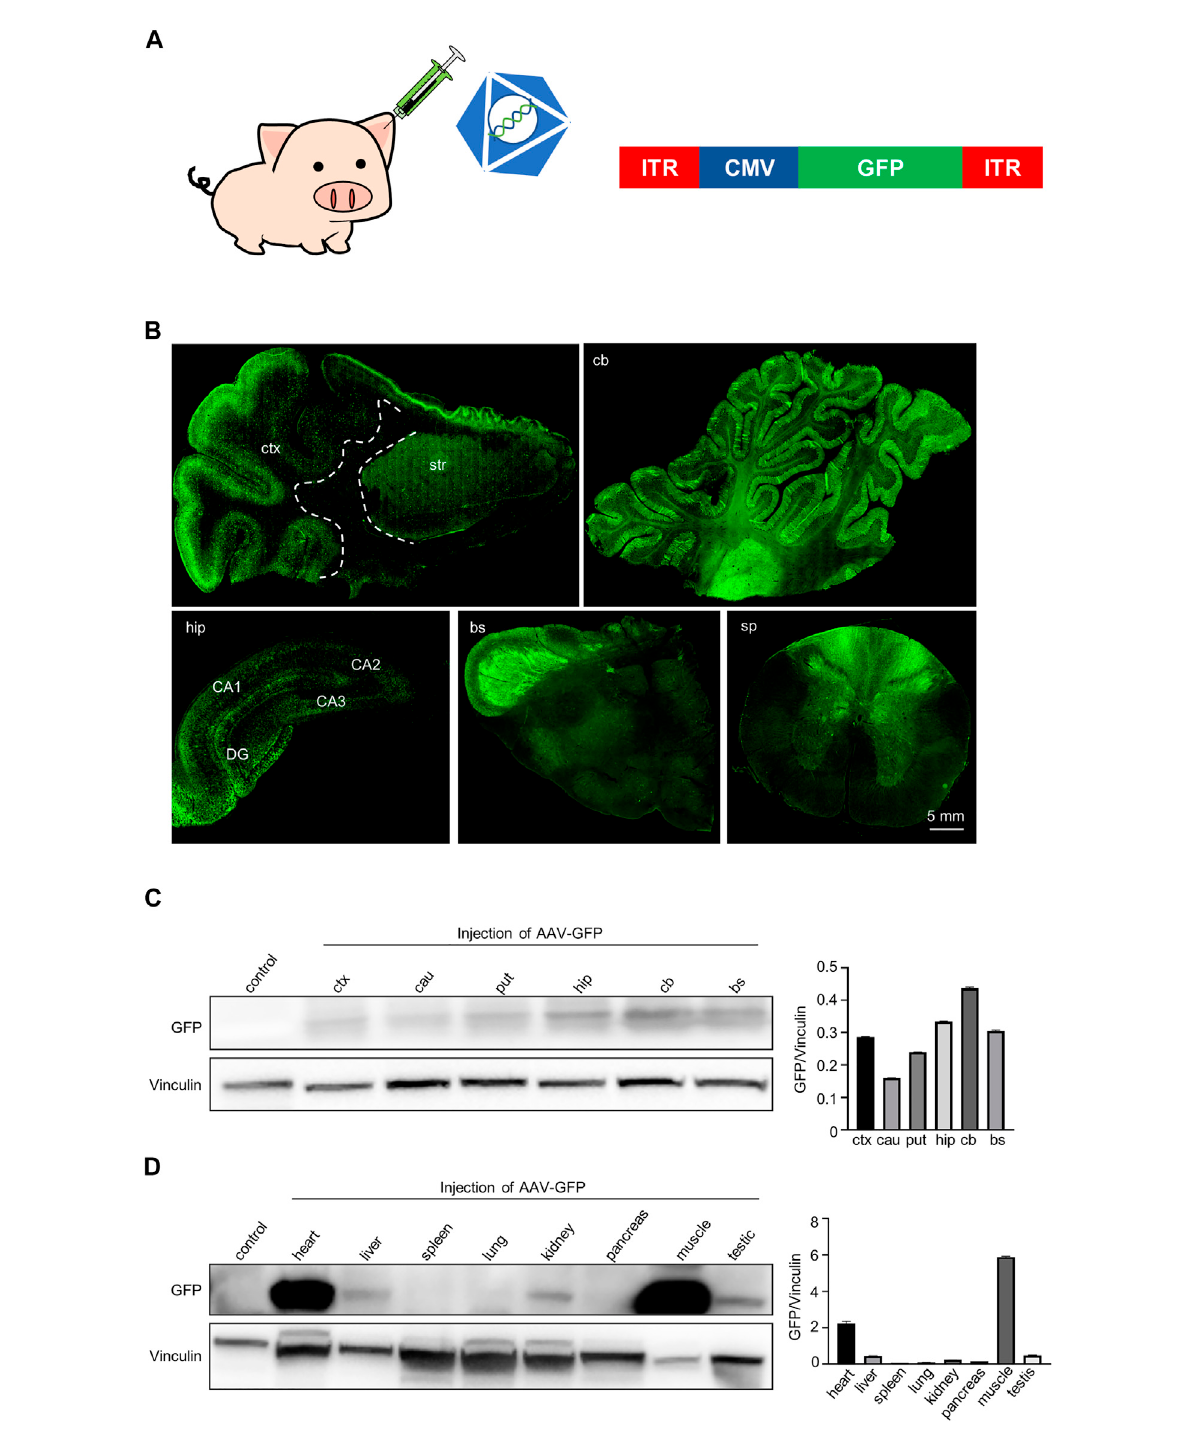
FIGURE 1 GFP expression in the pig brain, spinal cord and periphery tissues following intravascular administration. (A) Injection of AAV-CMV-GFP into 7- day-old Bamapigs via auricularvein.Salineservedasacontrol.AAV9serotypewasusedtopackageviruses. (B) Immuno fl uorescentstainingshowed that GFP wasexpressedinvariousbrain regions and spinal cord of pigs after AAV-CMV-GFP injection. Regionsare (clockwise fromupper left) cortex and striatum (ctx and str), cerebellum (cb), hippocampus (hip), brain stem (bs), spinal cord (sp). (C) Western blotting demonstrates that GFP was expressed in various brain regions of pigs. Vinculin served as a loading control (left). Quanti fi cation of the GFP expression in each brain region. Data are analyzed by Student ’ s T-test and presented as mean ± SEM (right). N = 3 animals per group. (D) Western blotting of GFP expression in various peripheral tissues of pigs. Vinculin served as a loading control (left). Quanti fi cation of GFP expression in each type of peripheral tissues. Data are analyzed by Student ’ s T-test and presented as mean ± SEM (right). N = 3 animals per